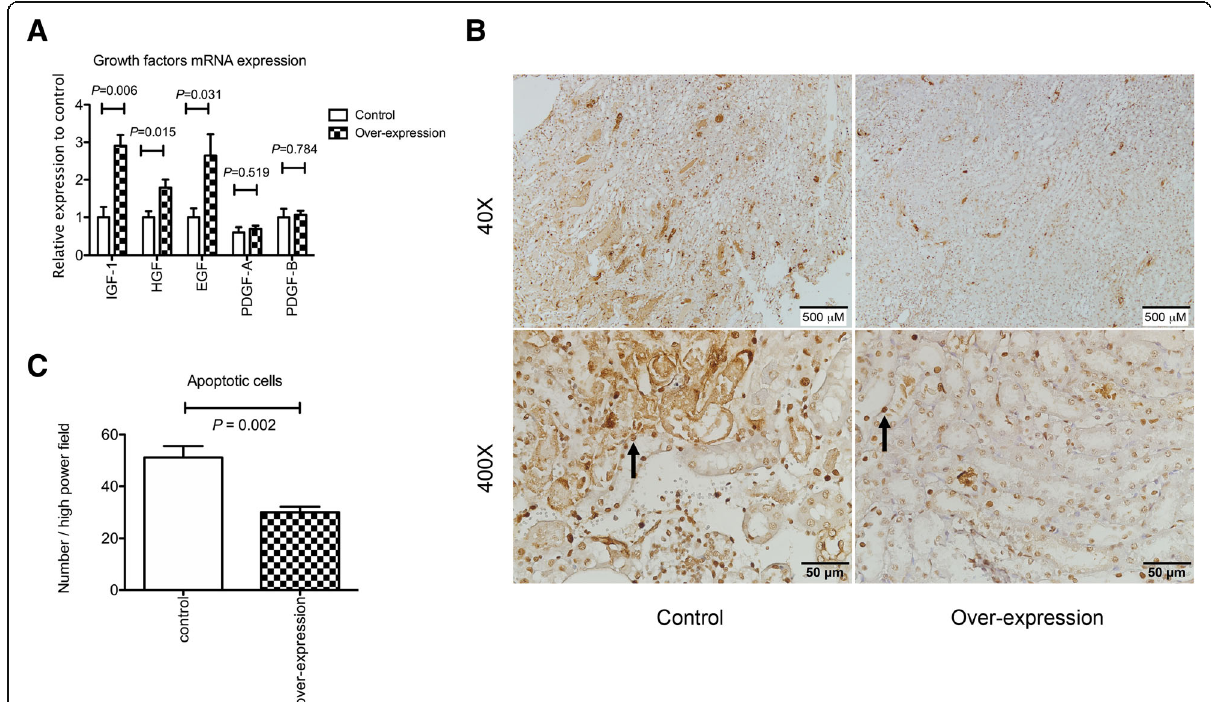
Fig. 10 a Growth factor genes expression in the whole kidney. The mRNA expression of EGF, HGF and IGF-1 was higher in the over-expression mice. There was no difference of PDGF-A and PDGF-B genes expression between the over-expression and control mice. ( N = 8 per group) b Apoptotic tubular cells revealed by TUNNEL staining in the kidneys. There were more apoptotic tubular cells in the control than the over- expression mice. Arrow indicates apoptotic cell. c Semi-quantitative analysis of the apoptotic cells ( N = 6 per